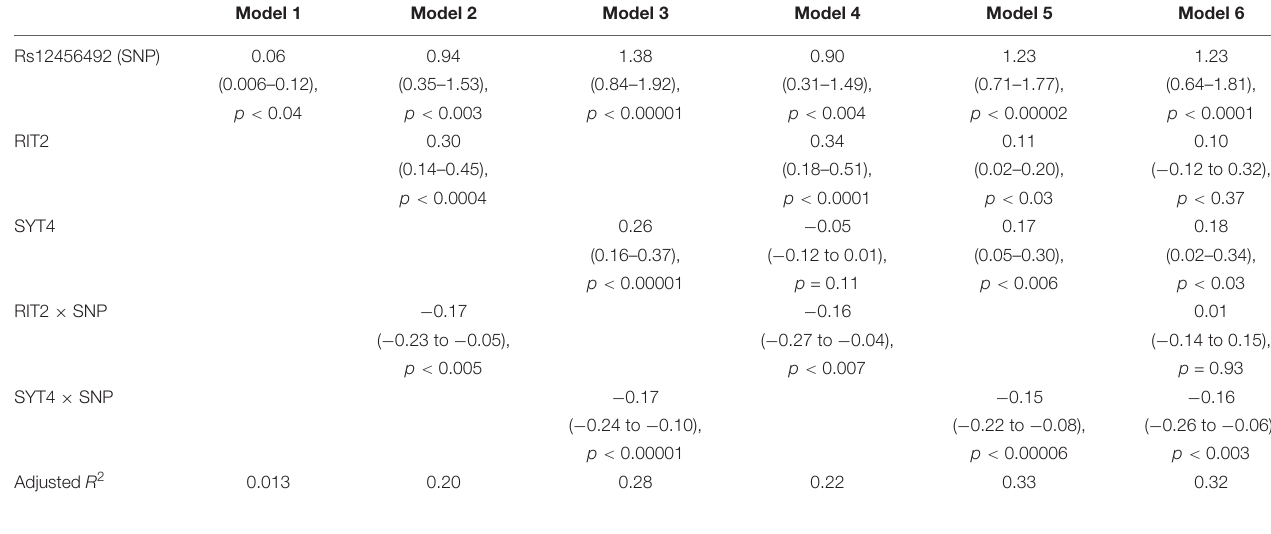
TABLE 2 | Effects of Rs12456492, RIT2 , and SYT4 gene expression on brain pH, with sex, age, postmortem interval (PMI) and RNA integrity number (RIN) as